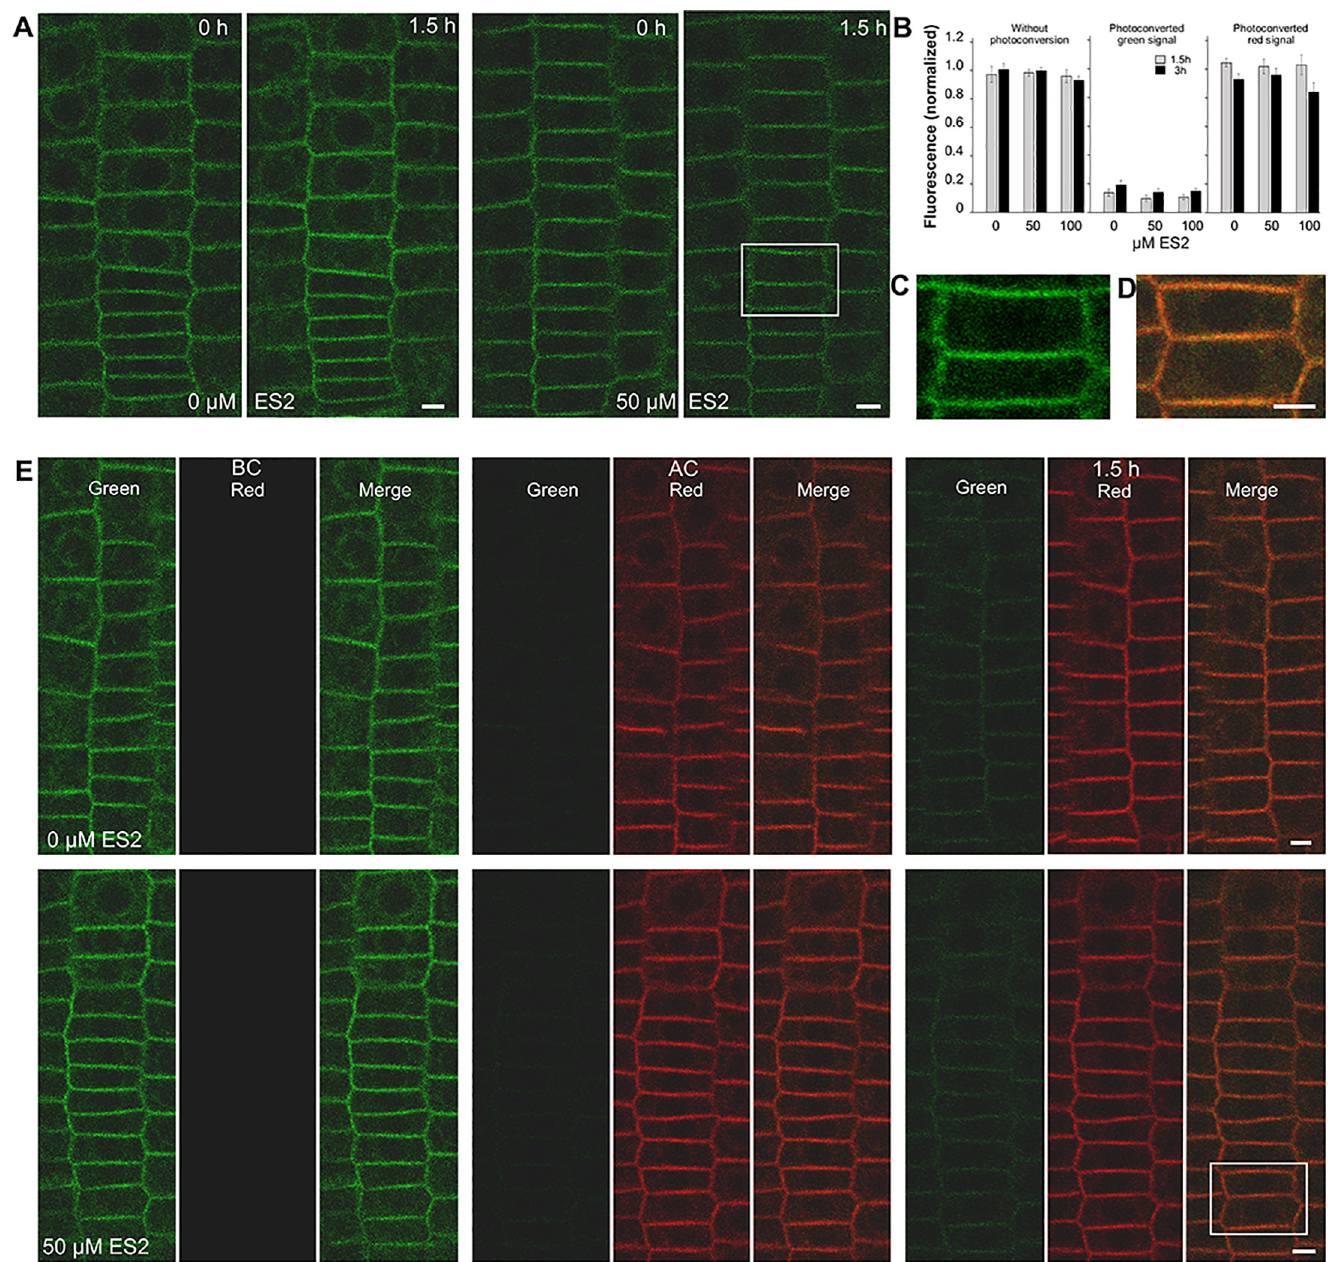
Fig 7. Endosidin2 has no apparent effect on SYT1 dynamics. In the experiment without photoconversion, roots were placed on the medium with different ES2 concentrations, immediately imaged and then reimaged after 1,5 and 3 hours. In the experiment with photoconversion, seedlings were placed on the medium with different concentrations of ES2, then roots were immediately imaged, photoconverted, imaged again, and reimaged after 1.5 and 3 hours. A figure shows a representative image taken during experiments without photoconversion, B shows an image captured during the experiment with photoconversion, C and D show magnified images of the rectangle areas in A and E, respectively. Note that the SYT1-Dendra2 fusion protein does not accumulate in vacuoles or aggregate in the cytoplasm. The B chart shows relative PM fluorescence intensities after 1.5 and 3 hours of treatment with 50 or 100 μ M ES2. In the experiment without photoconversion, the means of the PM’s signal intensities in roots were normalized to the mean of signal intensities of the PM of the same root before ES2 application. In the photoconversion experiment, the means of PM green signal intensities in the roots after the photoconversion were normalized to the mean of green signal intensities of the PM of the same root before photoconversion (BC in the figure). The means of red signal intensities were normalized to the mean red fluorescence intensity measured immediately after photoconversion (AC in the figure). The two-way ANOVA test showed statistically significant differences among time points (p � 0.05, n = 15) but no significant effect of ES2 treatment on green and red signal intensities in the photoconverting experiment. No effects were found in the experiment without photoconversion. Bars = 5 μ m.